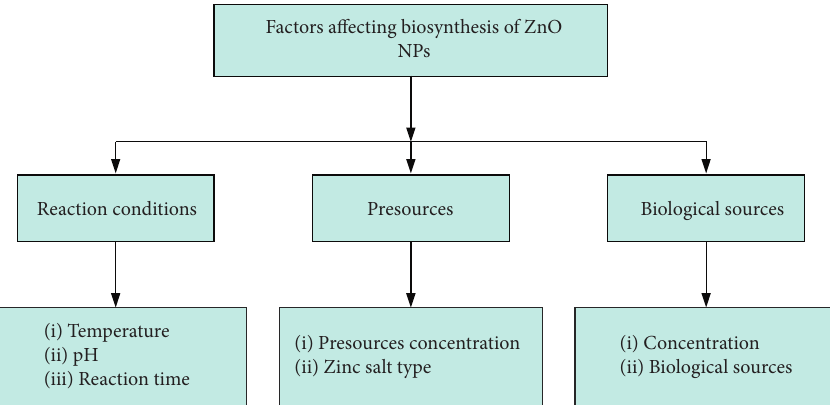
Figure 2: Factors’ effect on the biosynthesis of ZnO NPs.